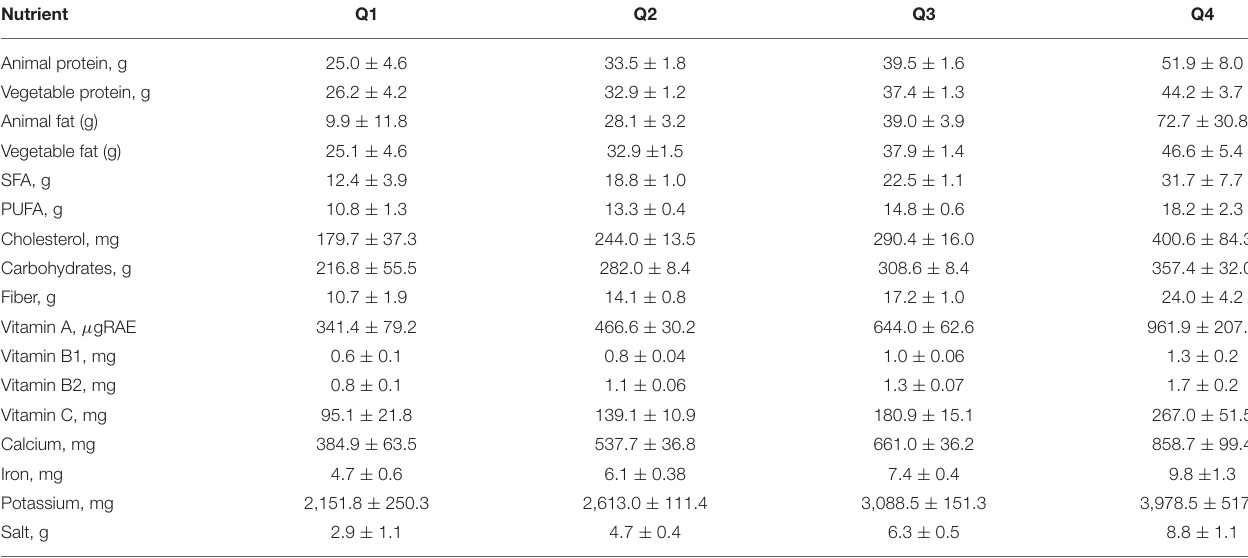
TABLE 3 | Mean daily energy-adjusted nutrient intake, by quartile. Nutrient Q1 Animal protein,